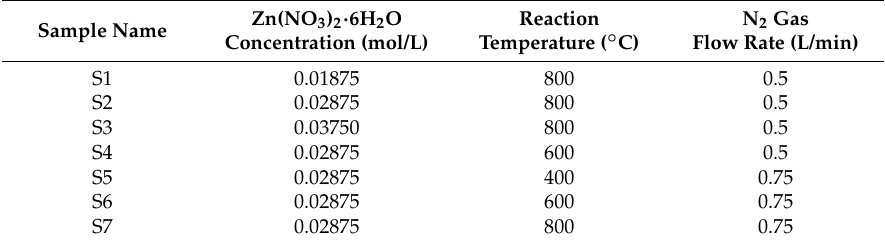
Table 1. Process parameters of nanostructured ZnO particles synthesized with various solution concentrations, reaction temperature and N 2 gas flow